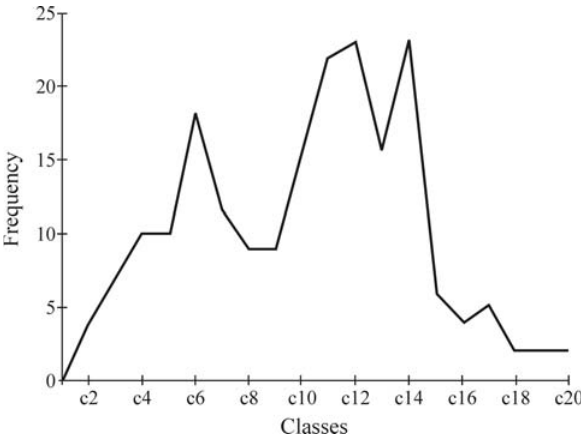
Figure 1 - Frequency distribution of area under the disease progress curve (AUDPC) values for late blight caused by Phytophthora infestans in F 2 generationofthetomatocross‘SantaClara’xBGH6902.Thevalueswere divided into 20 classes evenly distributed in the 45 to 550 interval.